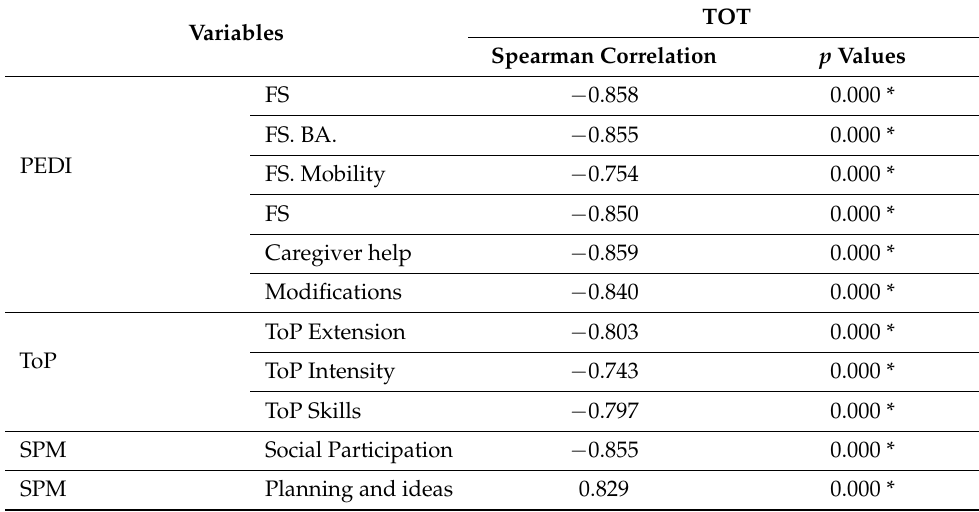
Table 5. Results of the relation between performance in DLA and sensory reactivity. Variables